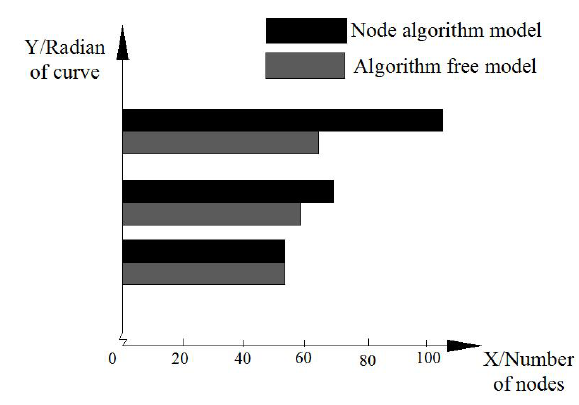
Fig. 4. Preliminary design of algorithm schematic